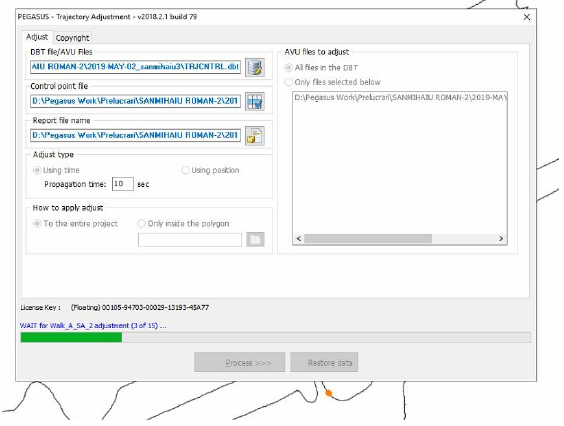
Figure 35. Time-adjusted trajectory processing on GCP checkpoints.